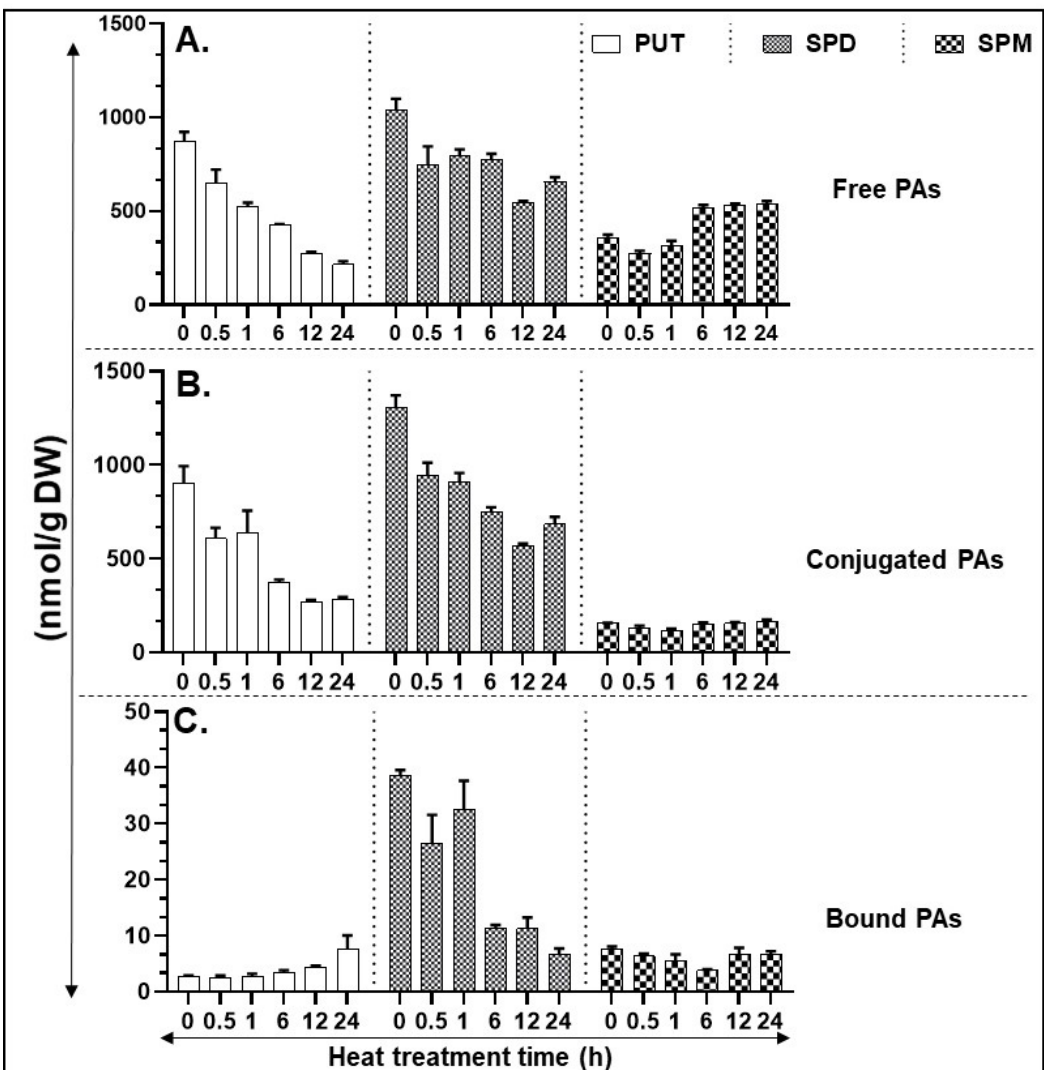
Figure 2. HPLC (high pressure liquid chromatography) based quantification of polyamines (PA) in heat-stressed tissues. ( A ) Free PAs—PUT, SPD, and SPM. ( B ) Conjugated PAs—PUT, SPD, and SPM. ( C ) Bound PAs—PUT, SPD, and SPM. A minimum of three leaves were excised from three plants for each biological replicate. Mean data points and standard error of a minimum of three biological replicates are shown. Statistical significance ( p -value) was derived using Graph prism pad program via Tukey test/t-test.